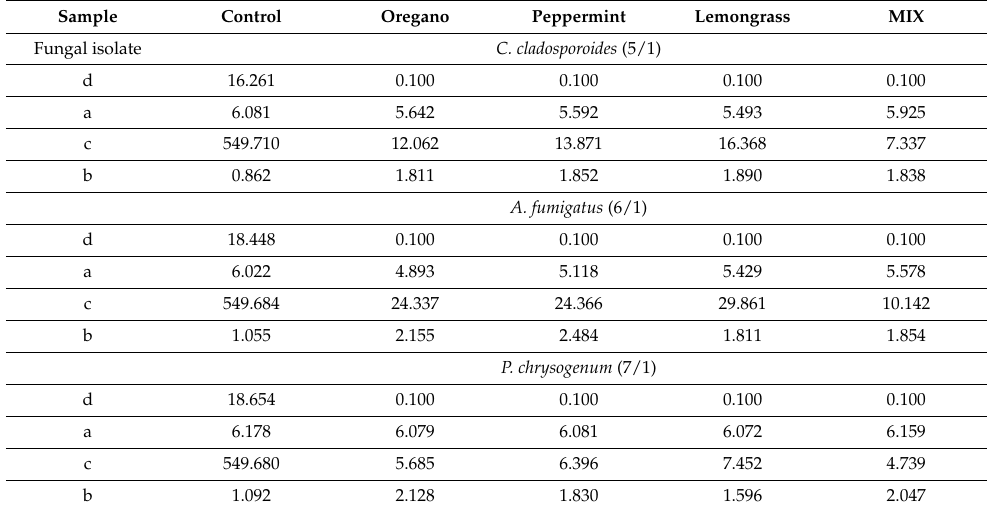
Table 3. Regression coefficients (a, b, c and d) for time-kill kinetics models (directed to Equation (2)).